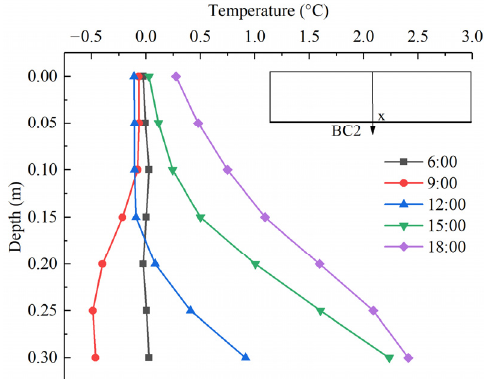
Figure 20. Temperature distributions of component T BC2 at different times.